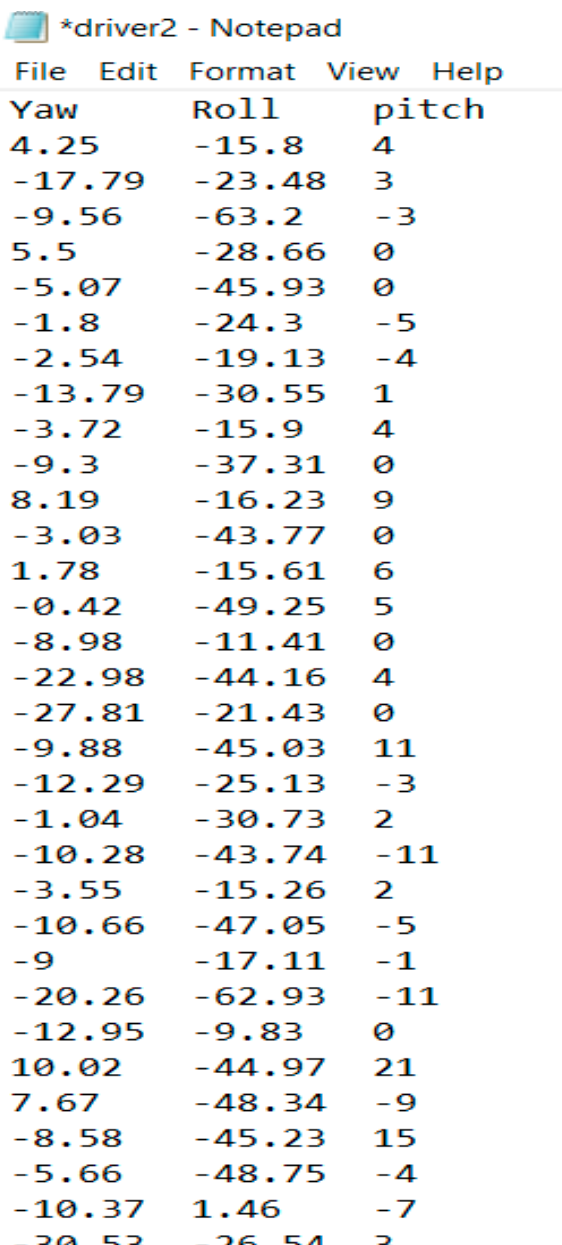
Figure 8. Sample of steering data recorded by raspberry pi in text format.